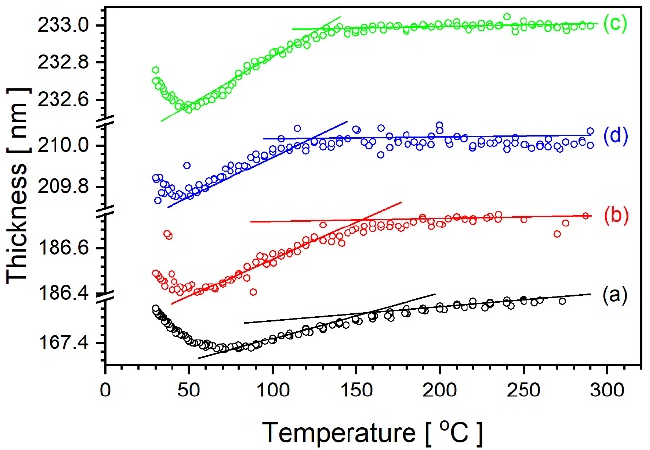
Figure 8. Thickness variation as a function of decreasing temperature for samples 50%—(a), 40%—(b),